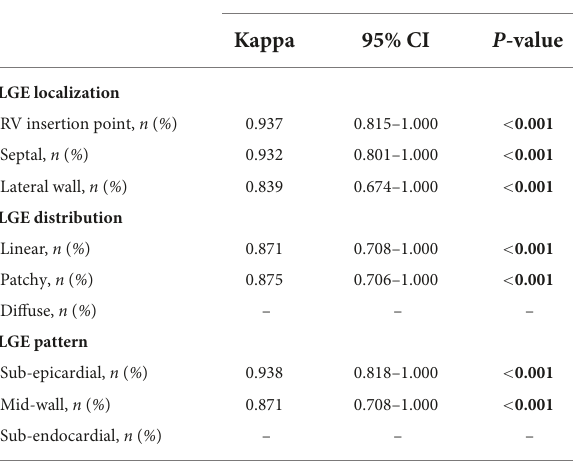
TABLE 4 Interobserver agreement of late gadolinium enhancement (LGE) location, distribution, and